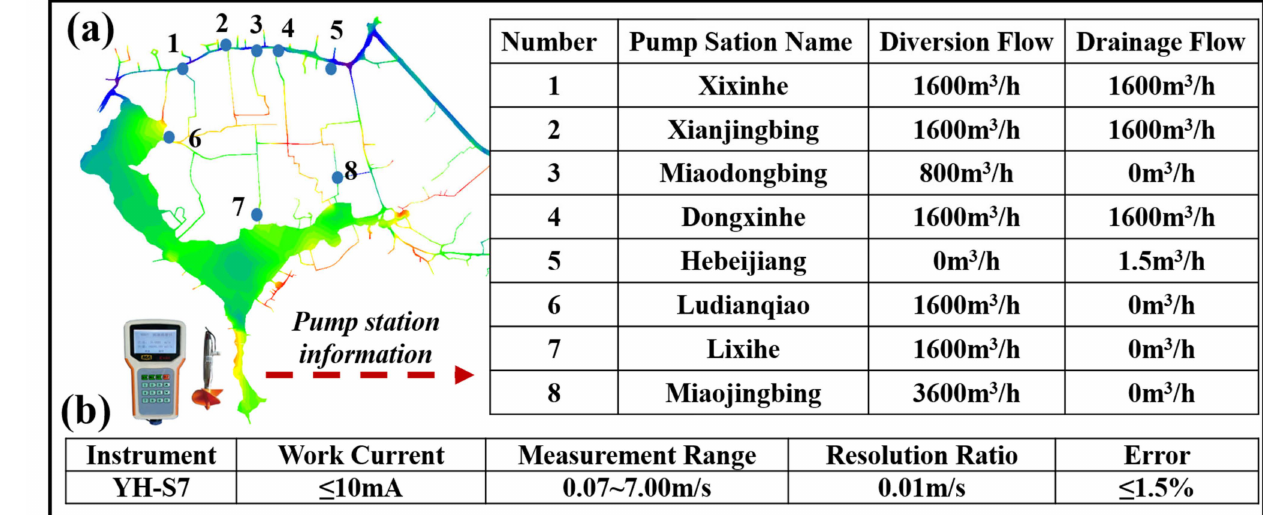
Figure 2. Statistic collection and analysis. ( a ) Pump station information of the river network ( b ) YH-S7 technical